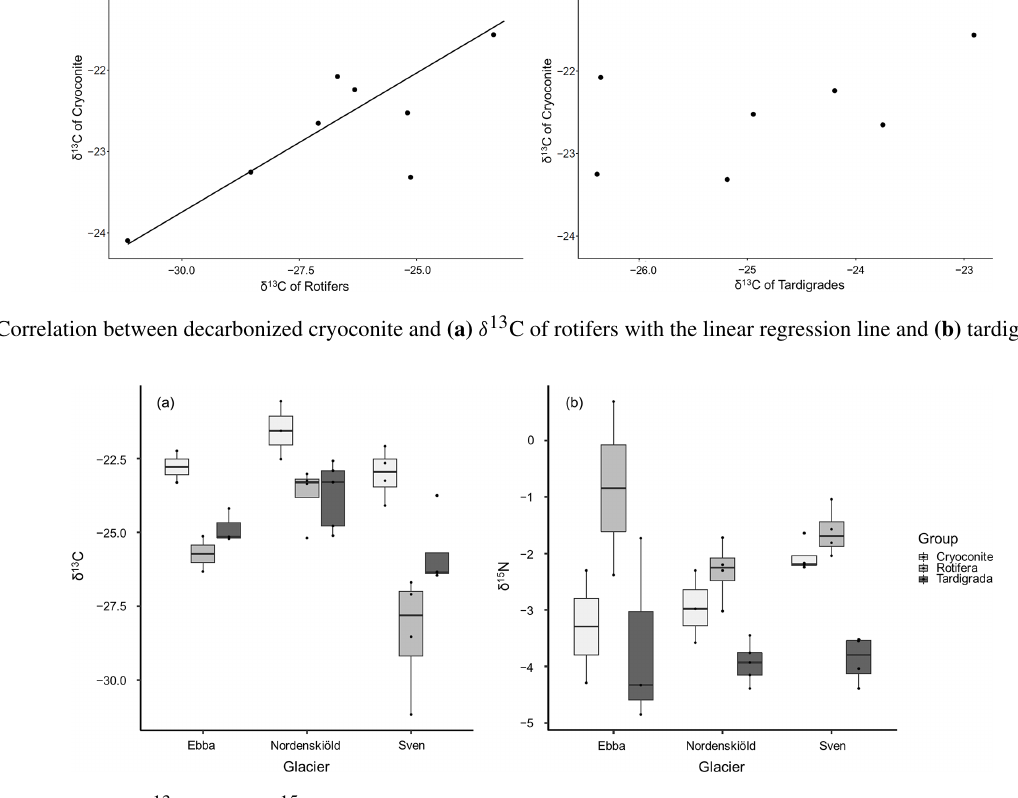
Figure 3. Distribution of δ 13 C (a) and δ 15 N (b) isotopic values in tardigrades ( n = 12), rotifers ( n = 10) and cryoconite ( n = 9) among glaciers. The differences in variances among glaciers are the result of the low number of replicates.